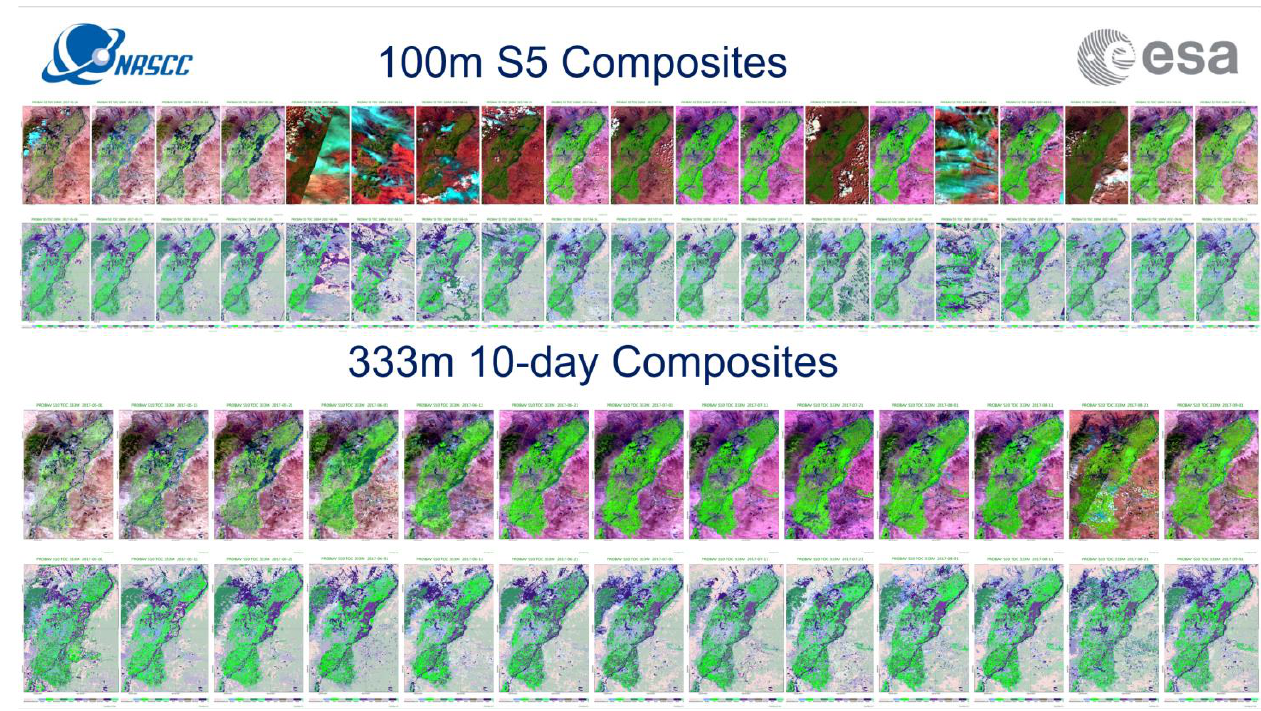
Figure 8. Crop type maps from individual medium-resolution satellite images of FY3B MERSI and PROBA-V.